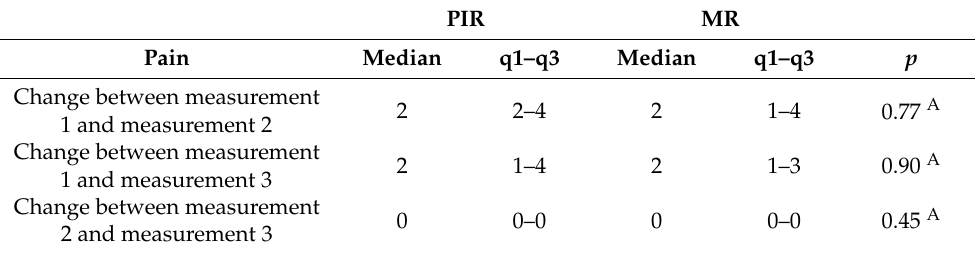
Table 7. Comparison of changes in the intensity of spontaneous pain in the masticatory muscles (Pain) for the VAS score assessed during the first study and follow-up between group I (PIR) and group II (MR). PIR MR Pain Median q1–q3 Median q1–q3